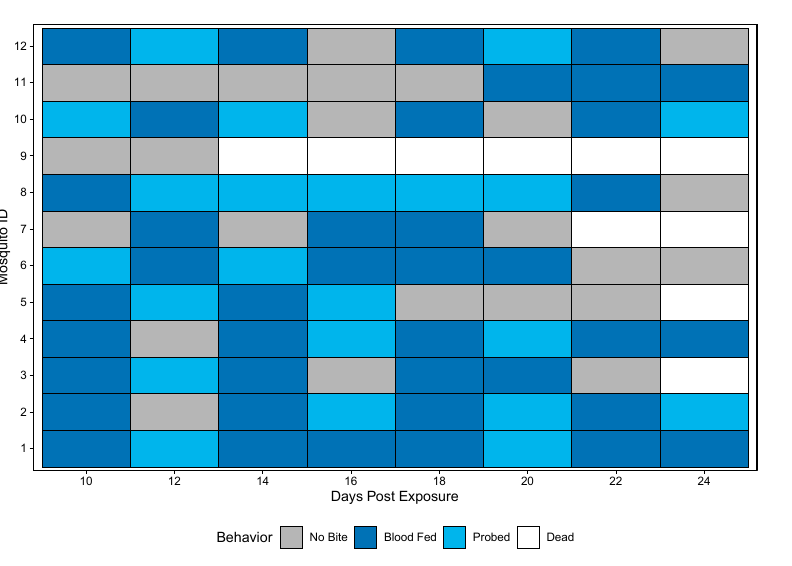
Figure 2. Biting behavior of Rockefeller individuals over the study period. Each row represents one mosquito across days post exposure. Each shaded square represents a potential transmission event, with mosquitoes being classified as no biting (grey), probing (light blue), and blood fed (dark blue). White squares indicate no opportunity (dead).